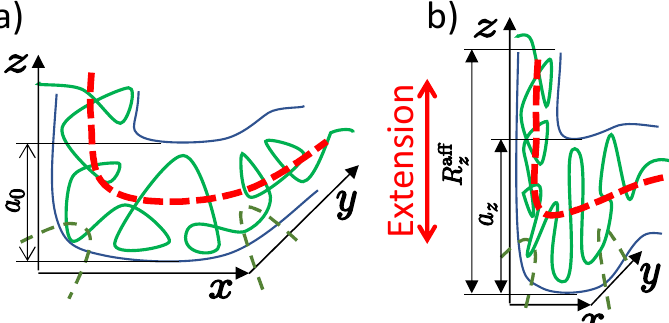
Figure 3. Nonaffine tube model. ( a ) In an undeformed state, the chain fluctuates in entangled tube of diameter a 0 ( b ) The tube diameter a z in the stretching direction is less than the affine length R af f z . The dashed lines show the trajectory of the primitive path, which is obtained by smoothing the affine deformed coordinates of the original Gaussian chain on the tube diameter scale a